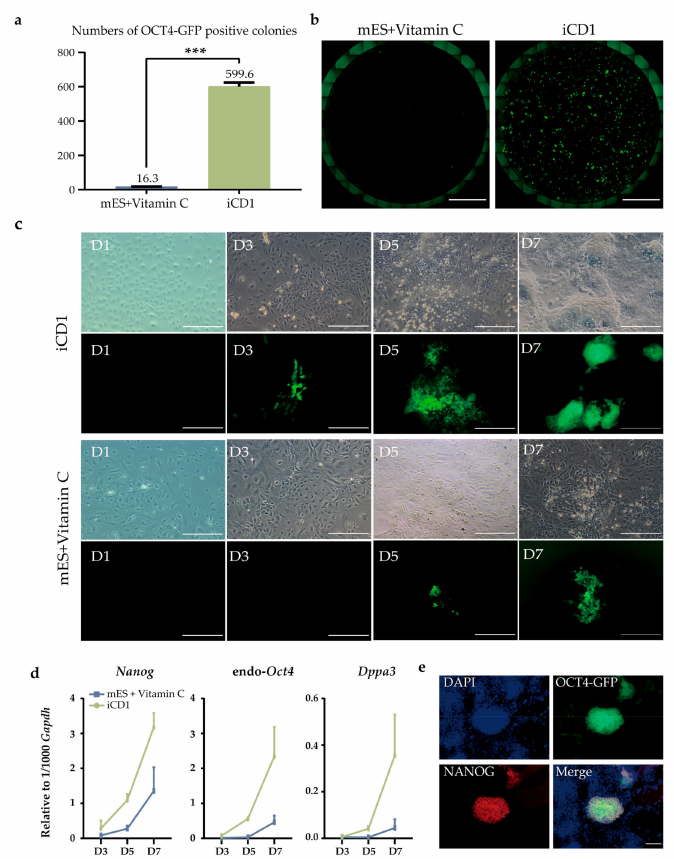
Figure 2. Characterization of generated iPSCs using the iCD1 medium. ( a ) Oct4-GFP-positive colonies were scored at day 7 post-treatment in indicated medium. *** p < 0.001, compared to the result of iCD1 (n = 2); ( b ) Images of Oct4-GFP positive colonies generated by indicated medium at day 7.